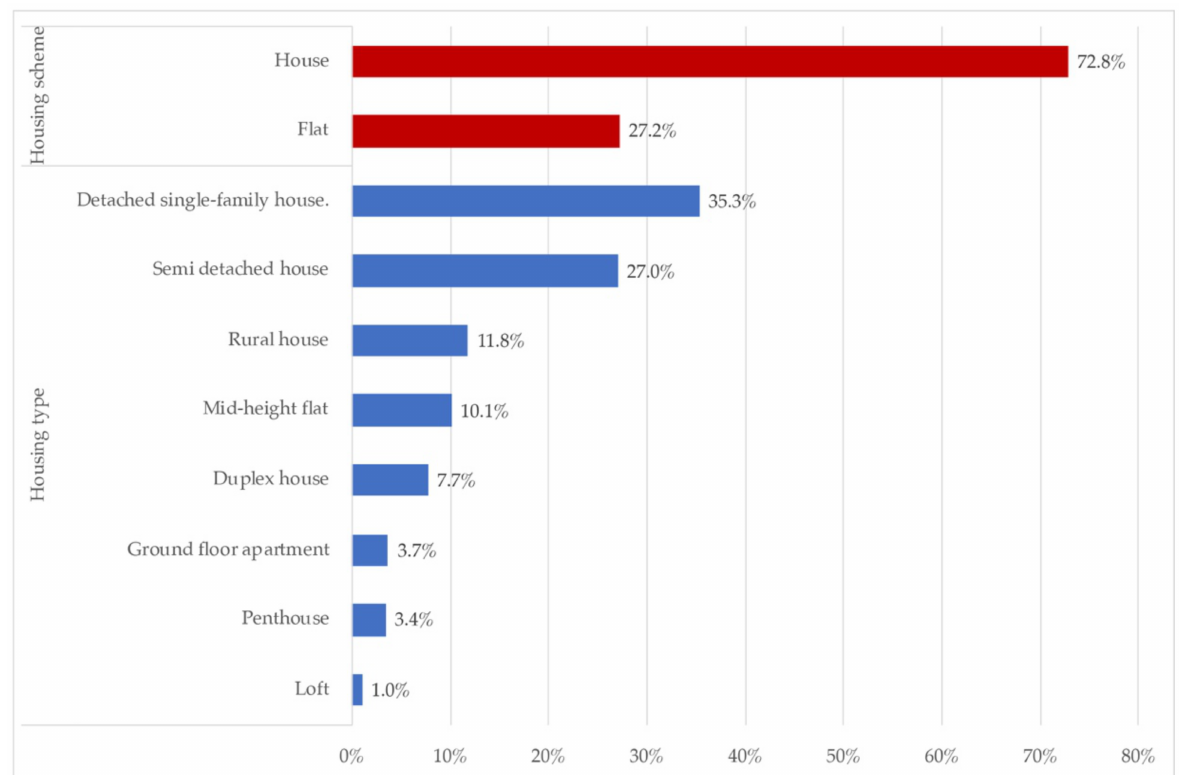
Figure 3. Schemes and housing types of the participating